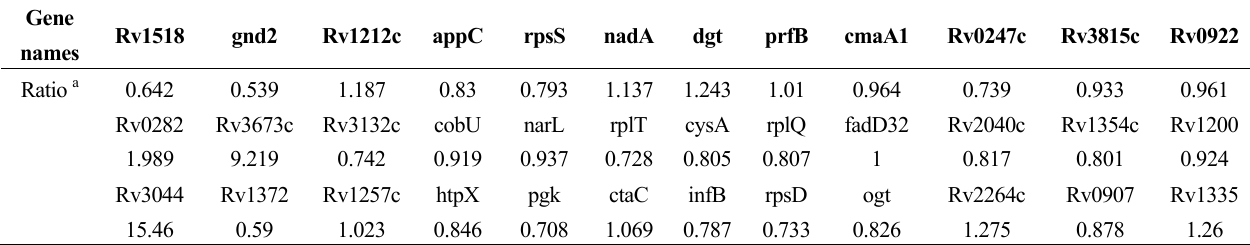
Table 3. qRT-PCR results demonstrating 4-deoxybostrycin-induced differential expression of M. tuberculosis H37Rv